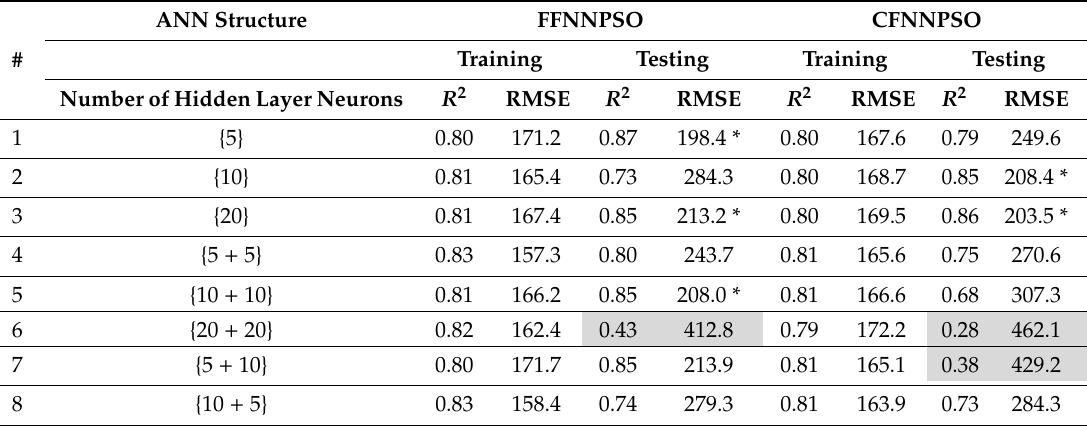
Table 6. Results on ANNs trained with 4 features ( x 1 , x 2 , x 4 , x 5 ) using the Particle Swarm Optimization (PSO) algorithm.